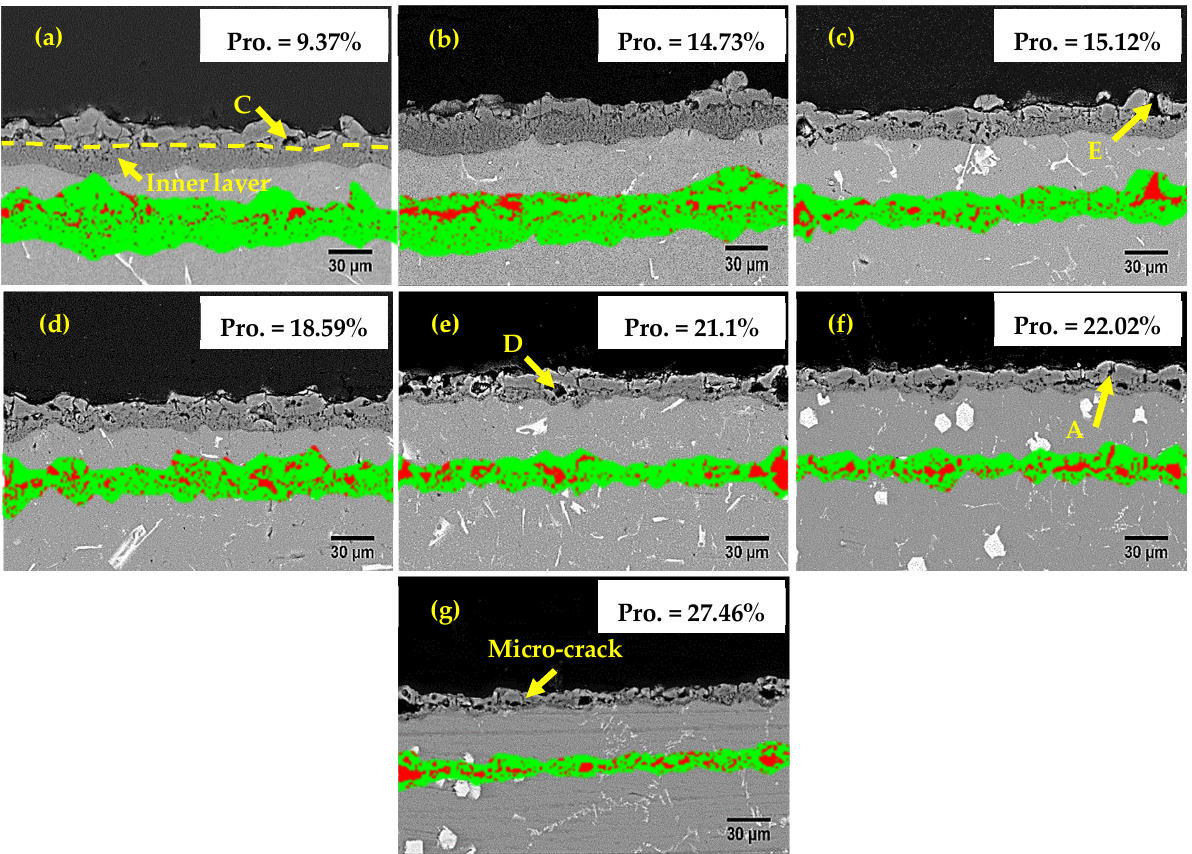
Figure 7. SEM images of cross-sections of the PEO-coated sample in the silicate-based electrolyte on different Al–Si alloys: ( a ) S1, ( b ) S3, ( c ) S5, ( d ) S7, ( e ) S9, ( f ) S11, and ( g ) S13. The images appended under each cross-sectional image show the porosity percent view obtained from MIP software.